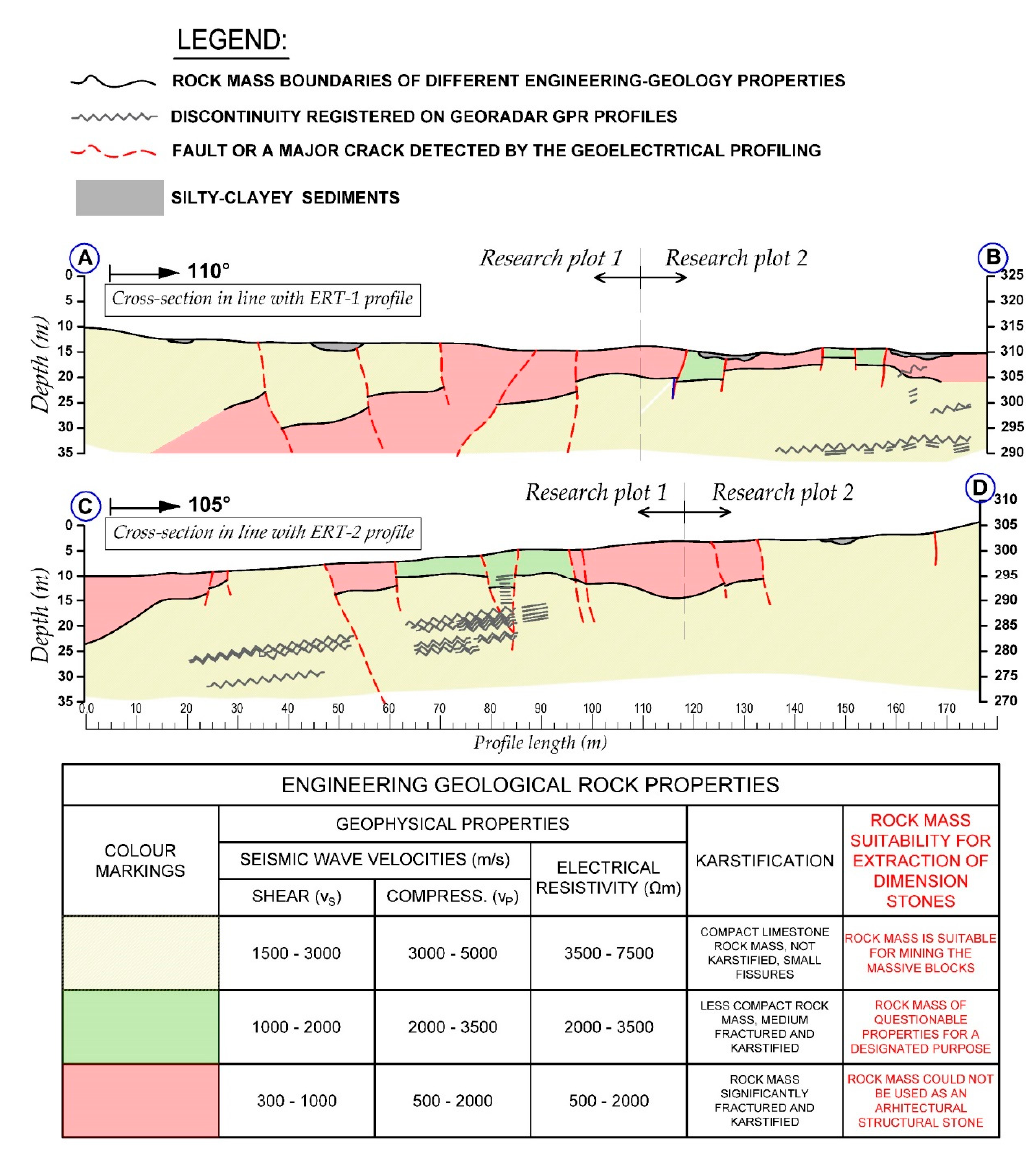
Figure 11. Final engineering geological sections derived from the geophysical data along the investigation site. Rock mass quality regarding dimension block mining is represented in the table by three categories. For each rock mass category, values of geophysical parameters are defined.